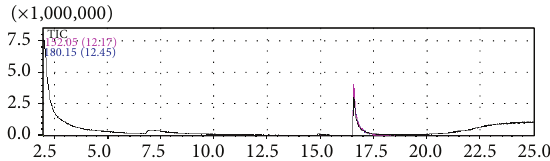
Figure 7: Chromatogram of GC-MS for standard 9,10- Anthraquinone and produced by oxidation of Anthracene before exposure to UV light.